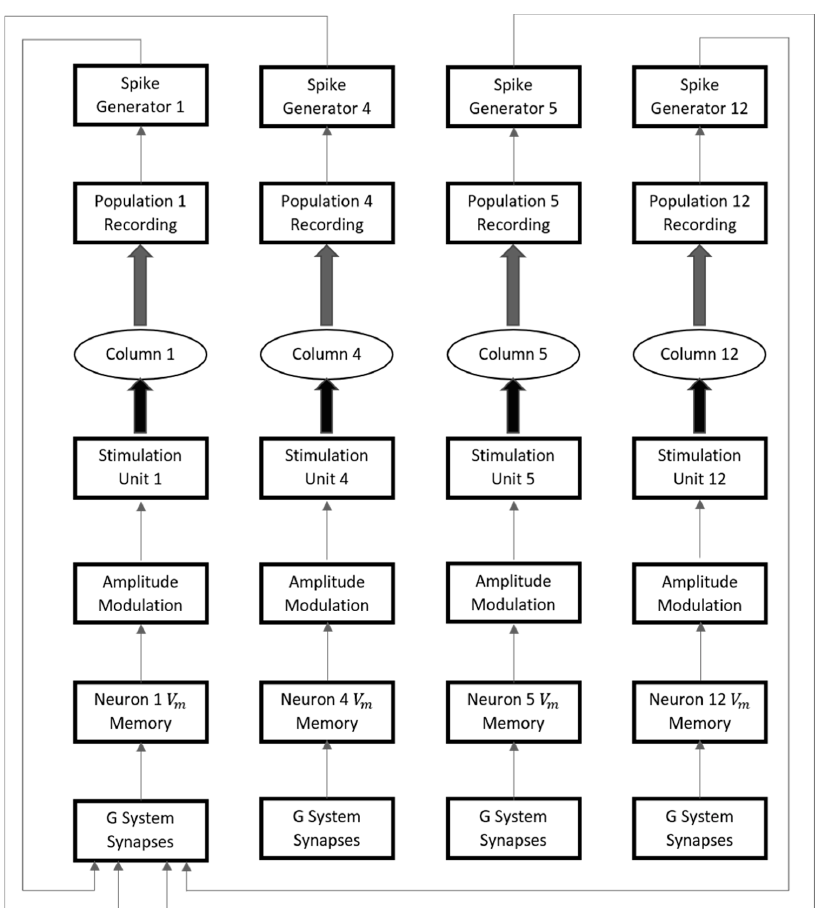
Figure 3. A simple block diagram illustrates essential features of how a neuromorphic device is proposed to complement a currently available CPV system. Each of the stimulation units receives input from the CPV system’s microprocessor which in turn receives video input and produces a mean stimulation amplitude that is either below or above the threshold for producing a phosphene.